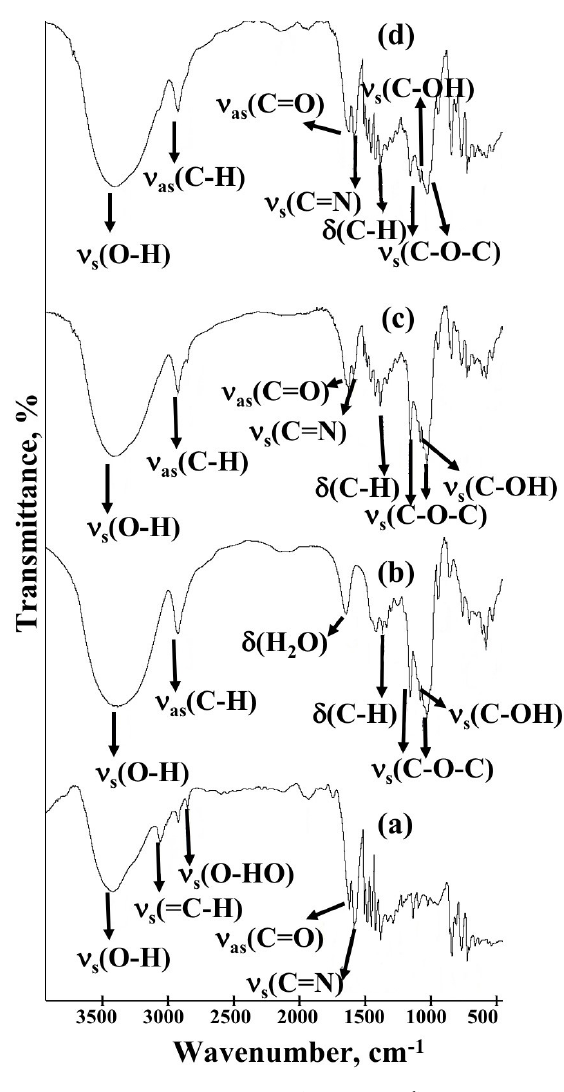
Figure 1. Absorption spectra (in KBr, cm -1 ) in the infrared region of [Ag(phen) ]salH (a), β-CD (b), solid 2 inclusion complex [Ag(phen) ]salH-β-CD (c) and 1:1 SS 2 of [Ag(phen) ]salH with β-CD 2